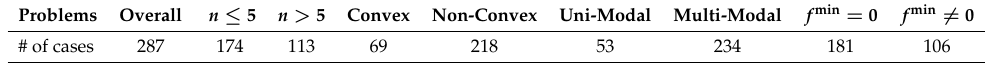
Table 1. Characteristics of DIRECTGOLib v1.2 test problems. Problems Overall